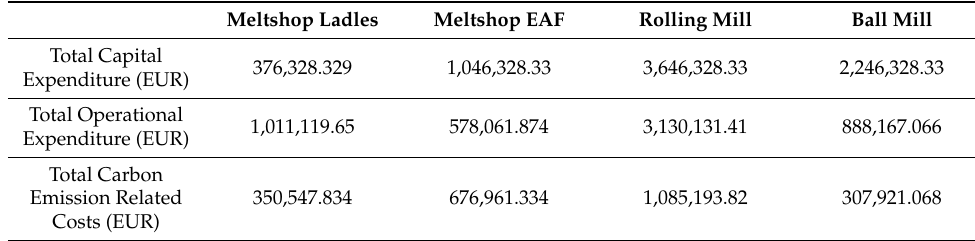
Table 7. Costs for energy efficient